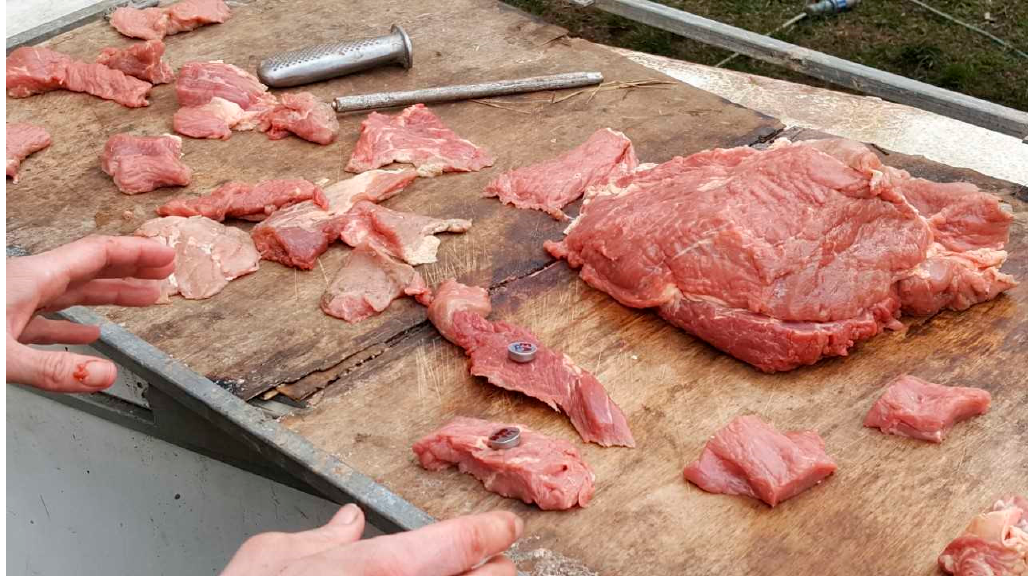
Figure 2. Preparing the Thermochrons to be fed to the lions. Each Thermochron was inserted into a small slit that was made in the chunks of meat to help insure the Thermochron was ingested.